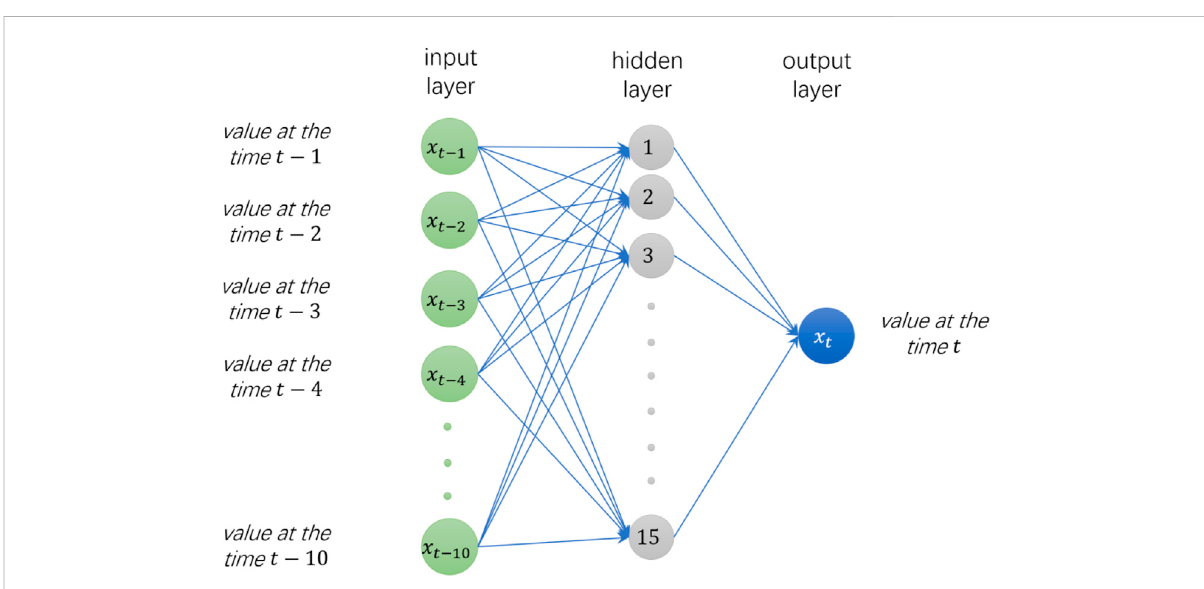
FIGURE 6 Topology of the time series-based ANN (TSANN) checking models for input parameters of the RPANN and for pressure of the primary-circuit